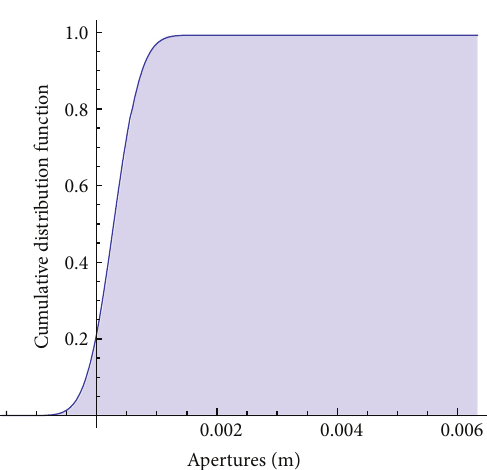
Figure 5: Cumulative distribution of the generated aperture (m) via Monte Carlo simulation.